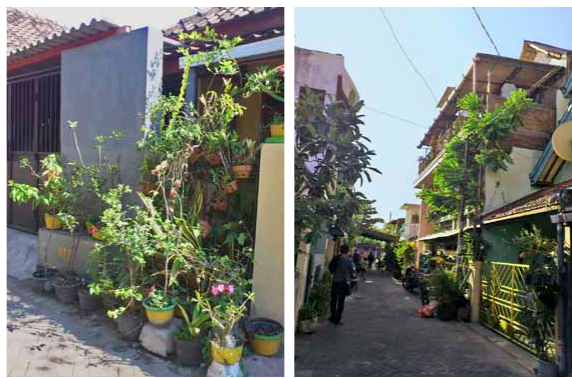
fig. 5. flowers planted in the pots independently by local residents (photo by the author)